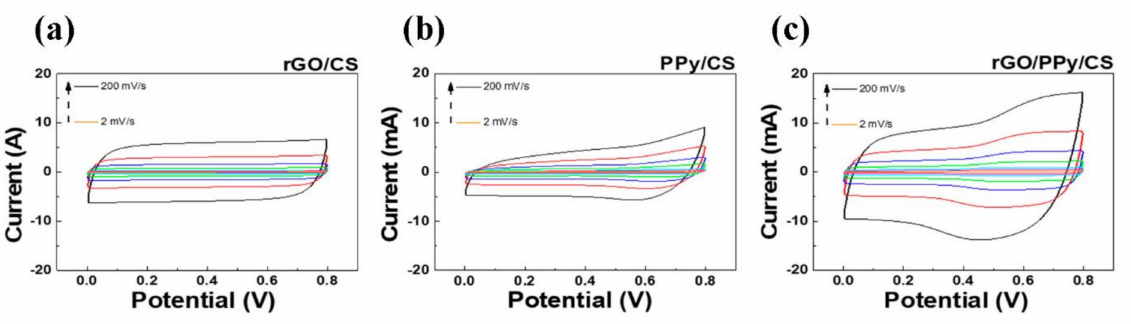
Figure 5. Cyclic voltammetry curves of ( a ) rGO/CS, ( b ) PPy/CS, ( c ) rGO/PPy/CS nanocomposite SCs at different scan